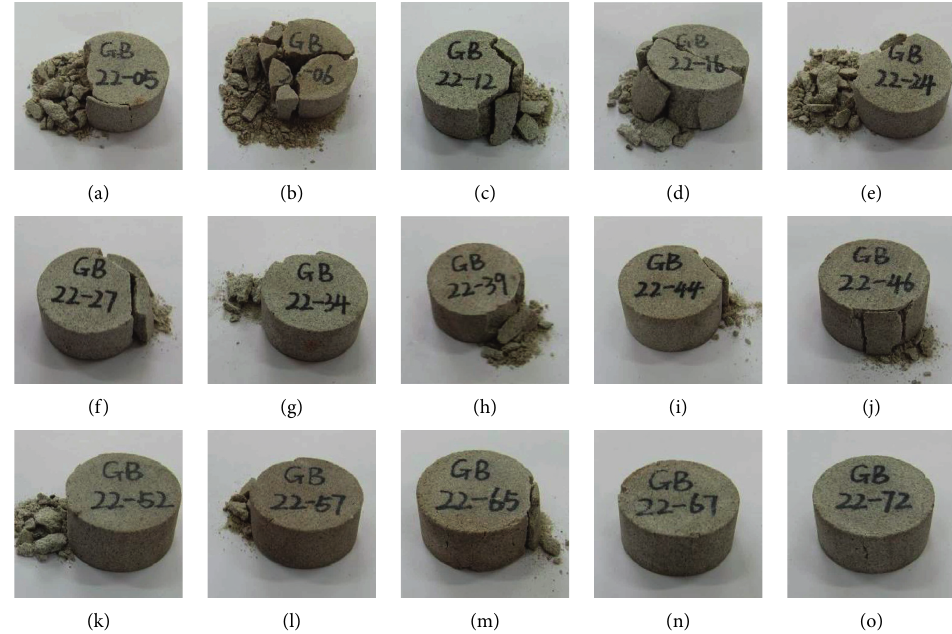
Figure 11: Dynamic compression failure modes of sandstone specimens with different water bath temperatures. (a) 25 ° C. (b) 30 ° C. (c) 35 °